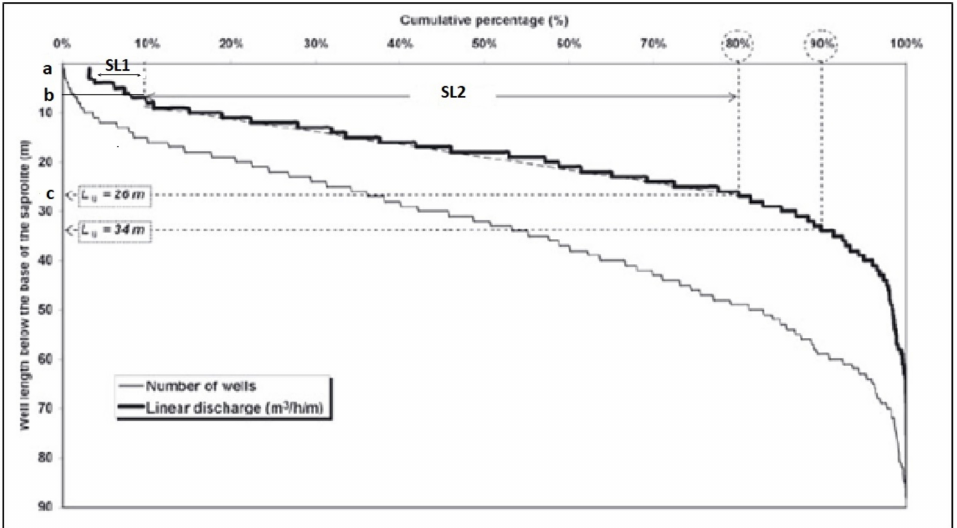
Figure 5. Cumulative percentage of linear discharge (X, %) as a function of the well length below the base of the saprolite (Y, m) to estimate the properties of the fractured layer for porphyritic biotite granite with 904 wells in Burkina Faso ([24] modified, Wiley-Blackwell Publishing, Inc., 10 November